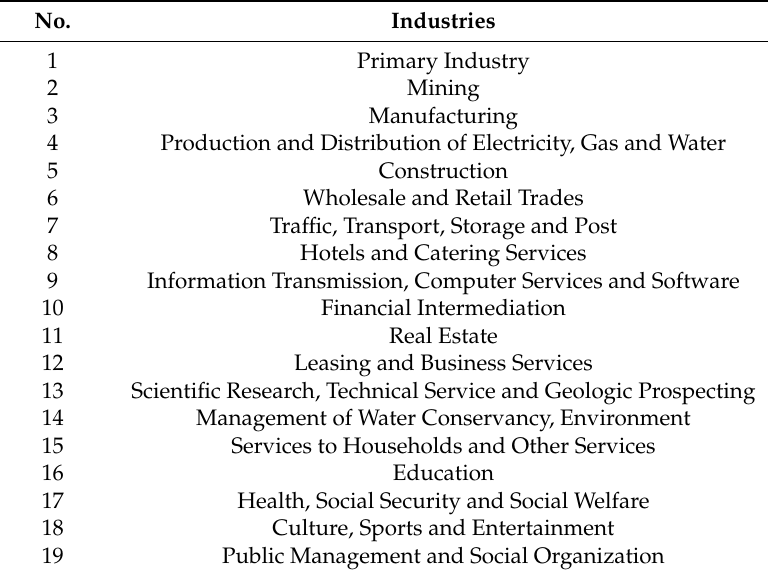
Table A1. List of 19 industries in China.